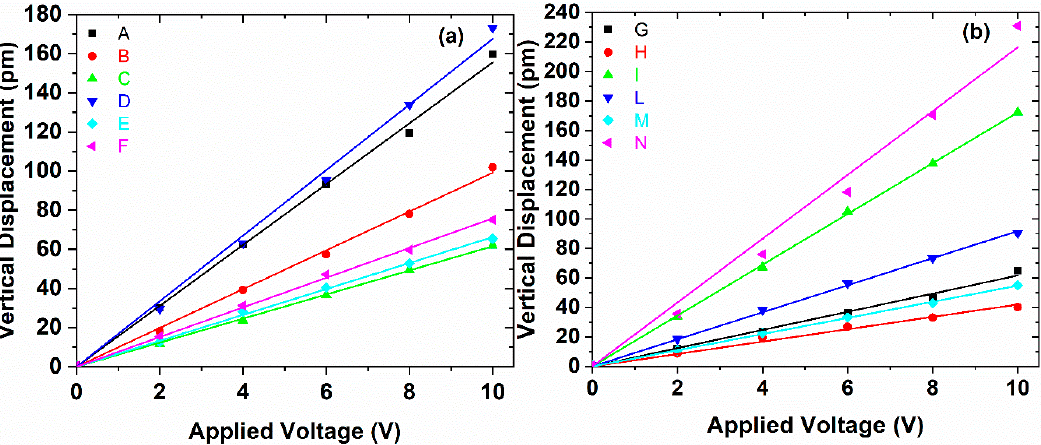
Figure 7. The average amplitude of the vertical displacement, measured through PFM as a function of the applied voltage V ac : For the PVDF samples at 20 wt.% at different temperatures and spinning speeds ( a ) and for the PVDF samples at 30 wt.% at different temperature and spinning speed ( b ).